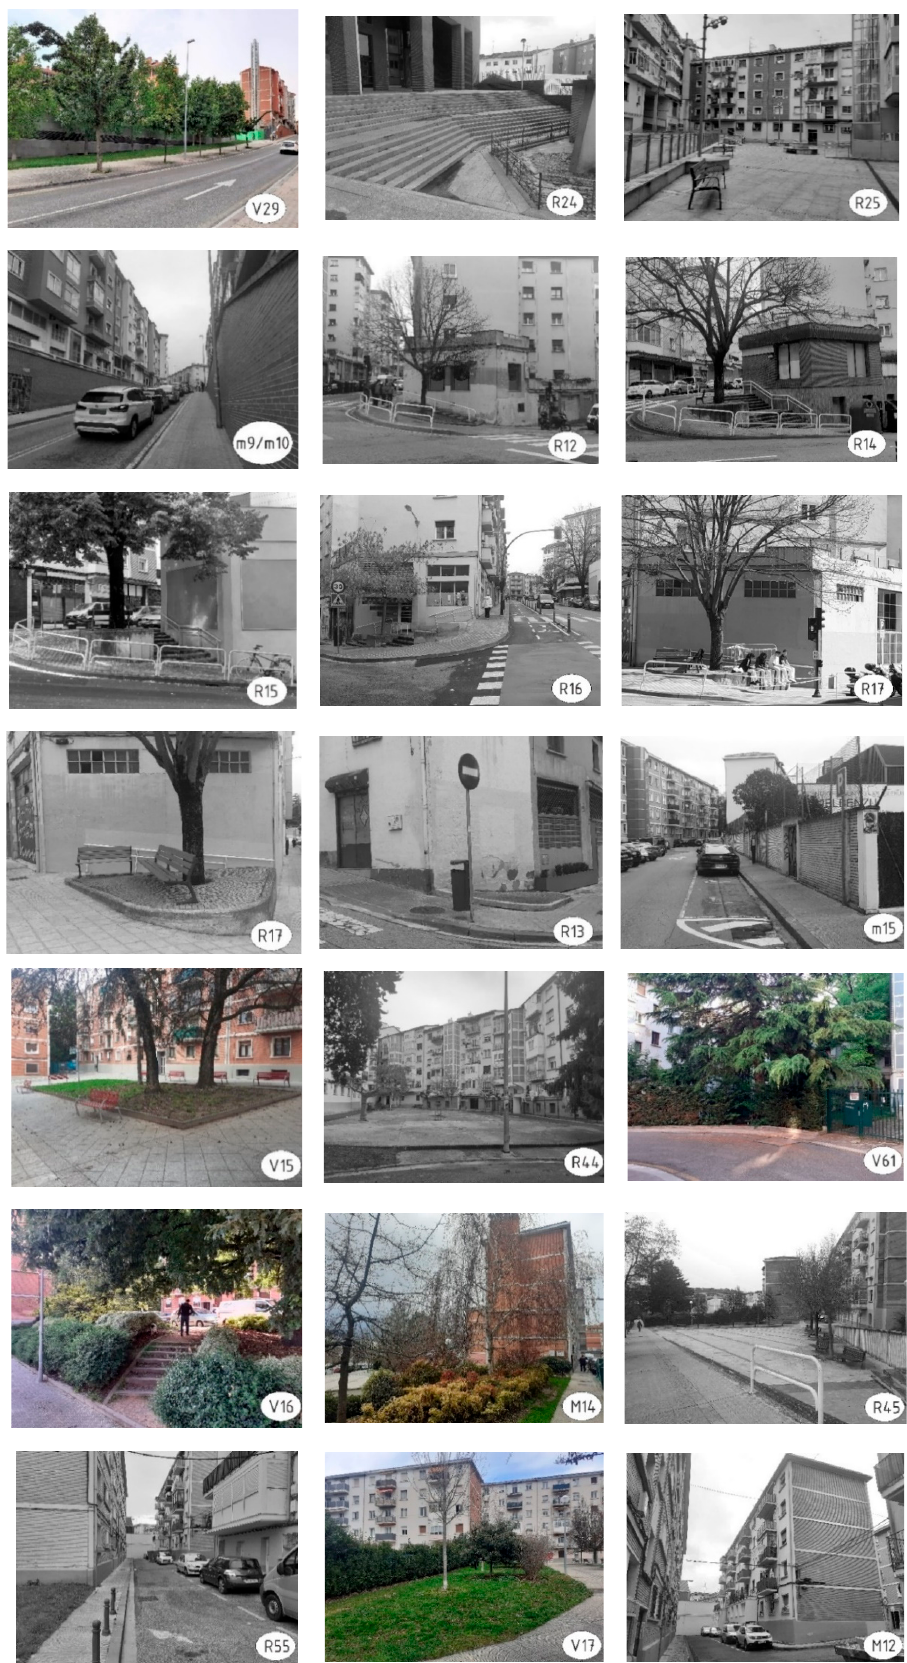
Figure 20. Sequence of images corresponding to the spaces of corridor 1.